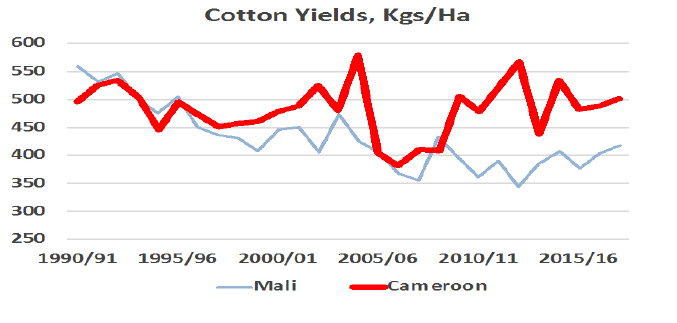
Figure 3: Cotton Yields Cameroon- Mali from 1990-2016